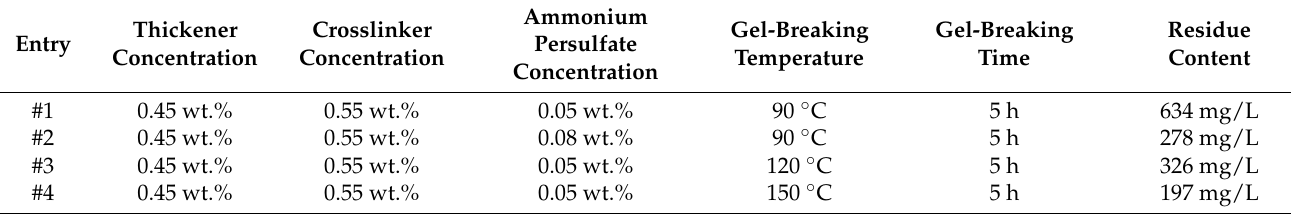
Table 8. Gel-breaking fluid residue